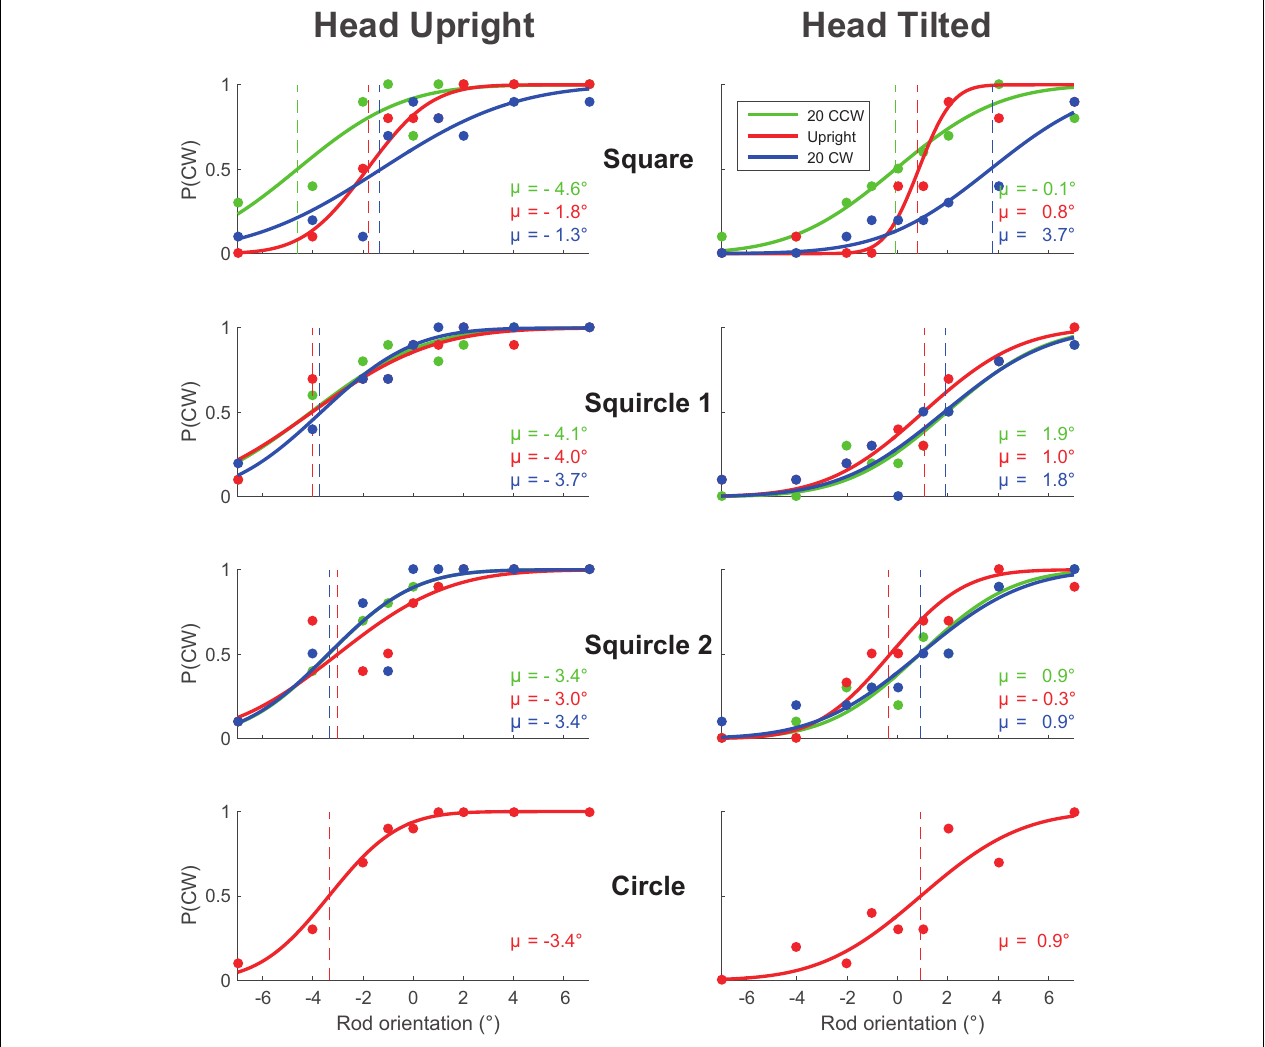
FIGURE 2 | The lines represent the psychometric curves that best fit the data of one of the participants. The raw data points (proportion of CW responses) are shown as circles. Panels on the left correspond to the head upright condition, to the right to the head tilted condition. The panels from top to bottom correspond to the used frame forms: square, squircle 1, squircle 2, and circle. The different colors represent different frame orientations (green, 20 degrees CCW; red, 0 degrees; blue, 20 degrees CW). CW, rotated clockwise; CCW,